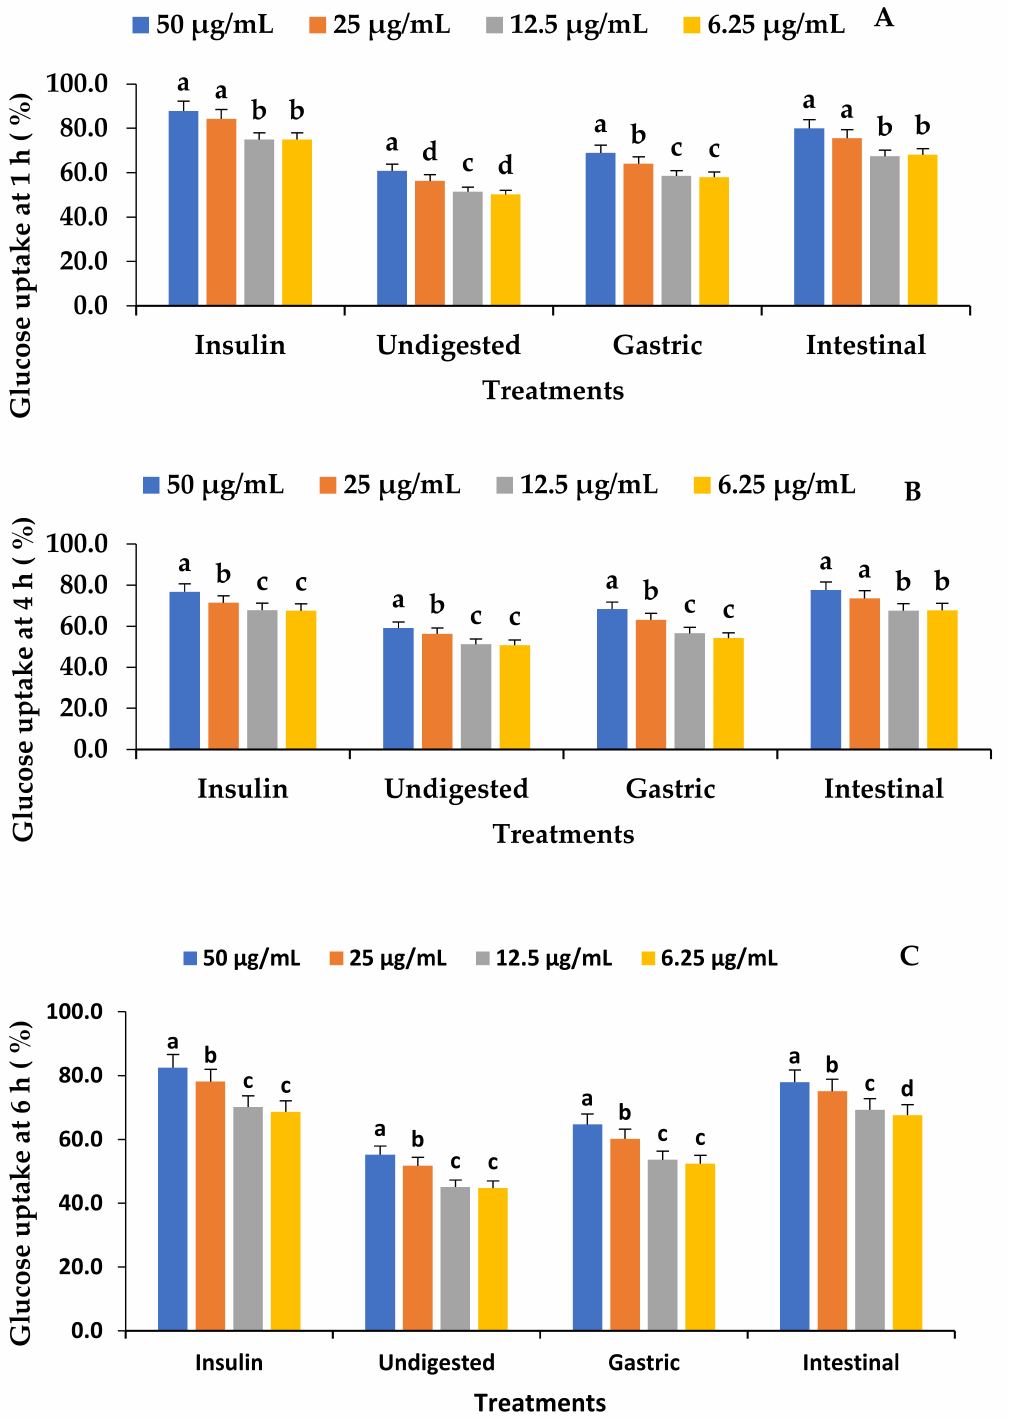
Figure 3. The effect of the in vitro digestion of VOP 1 cowpea leaf smoothies fermented by Ltp. plantarum 75 on muscle cell C 2 C 12 glucose uptake at 1, 4, and 6 h. The data presented